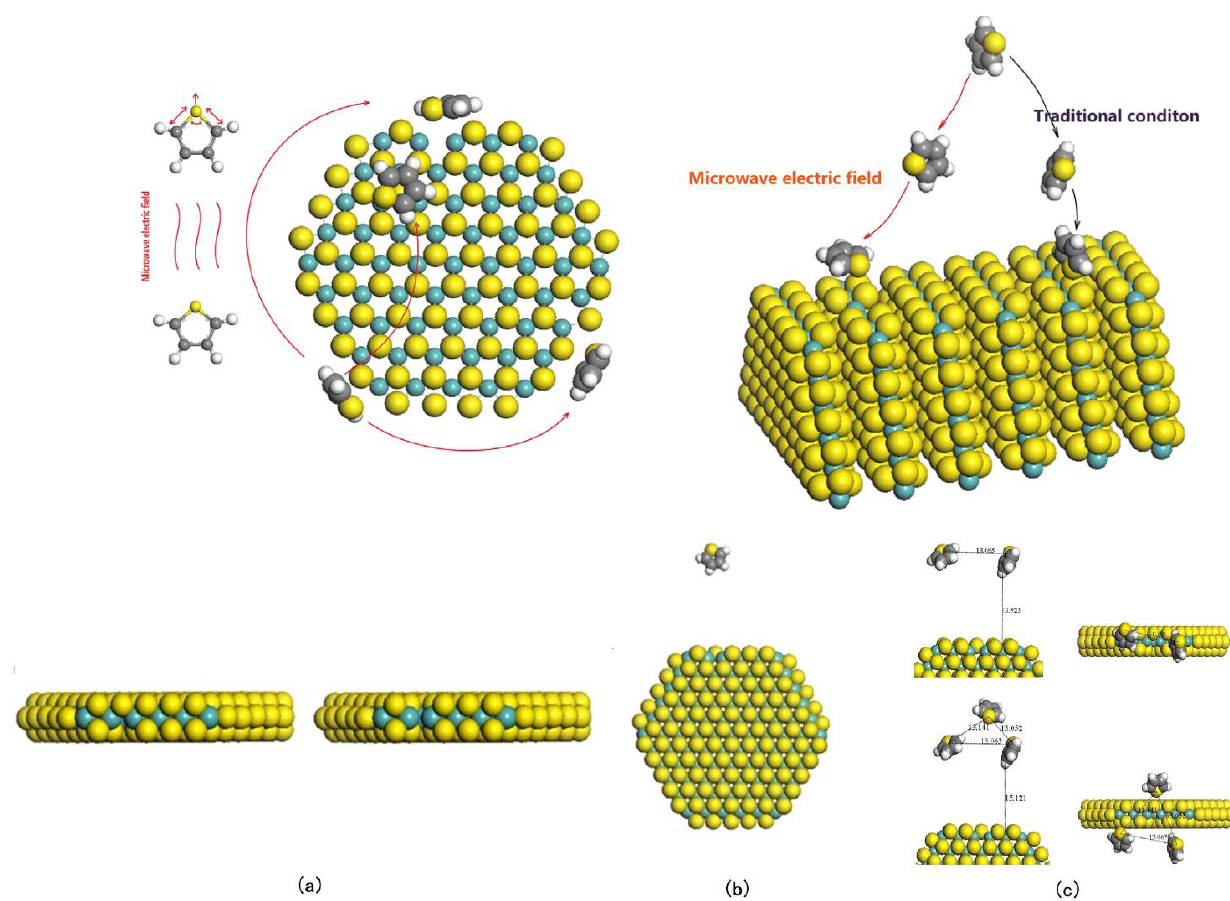
Figure 4. Adsorption model of ( a ) sulfur S and sulfur 2S vacancies on the MoS 2 cluster from the top view, ( b ) single thiophene adsorption; ( c ) two and three thiophene molecules adsorption. Reproduced with permission from [71], Copyright Elsevier, 2020.